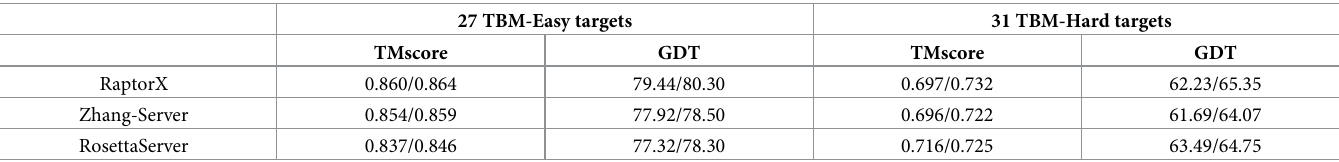
Table 5. The performance of three top servers on the CASP14 TBM targets. Each entry has the average quality score of the 1st-ranked and the best of top 5 models. 27 TBM-Easy